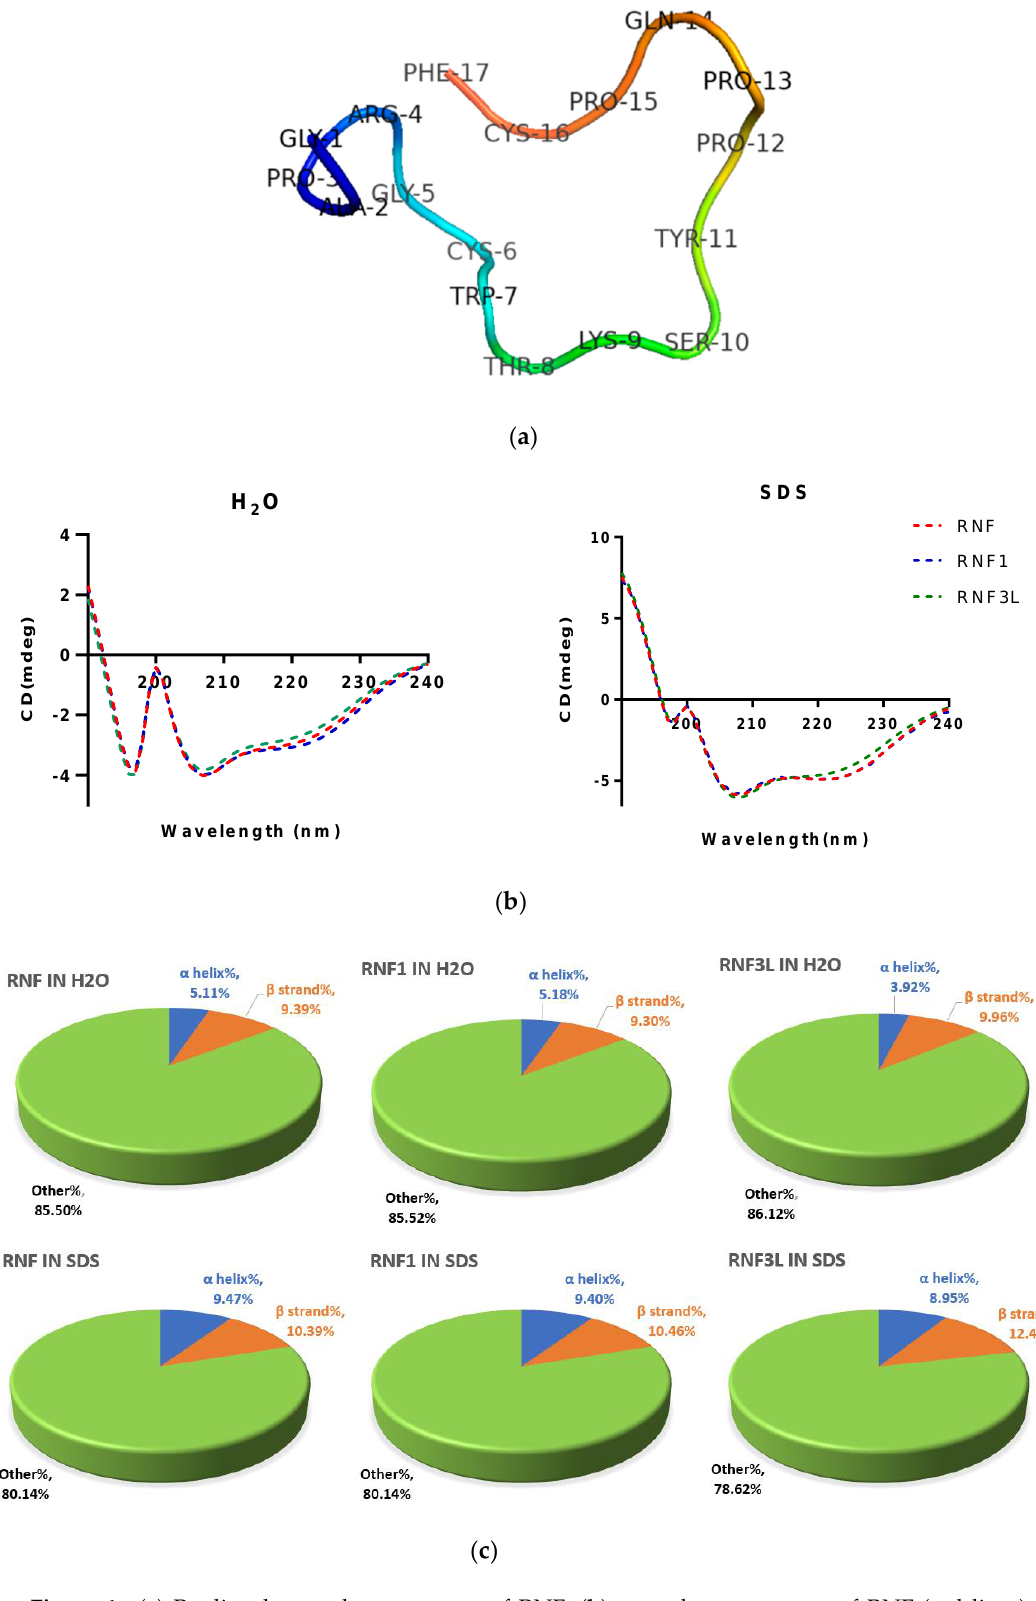
Figure 4. ( a ) Predicted secondary structure of RNF; ( b ) secondary structures of RNF (red lines), RNF1 (blue lines) and RNF3L (green lines) measured in ddH 2 O and 30 mM SDS buffers; and ( c ) proportion of different secondary structure domains predicted and calculated by K2D3.